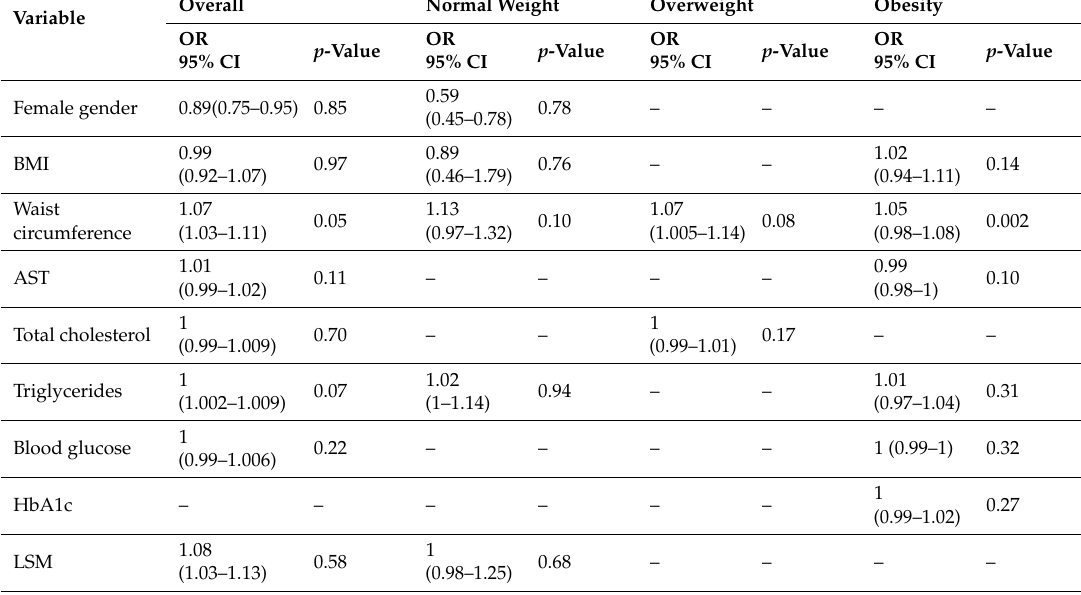
Table 4. Multivariate analysis of factors associated with severe steatosis.